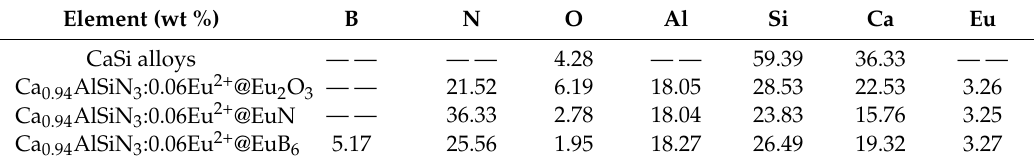
analytical data of CaSi